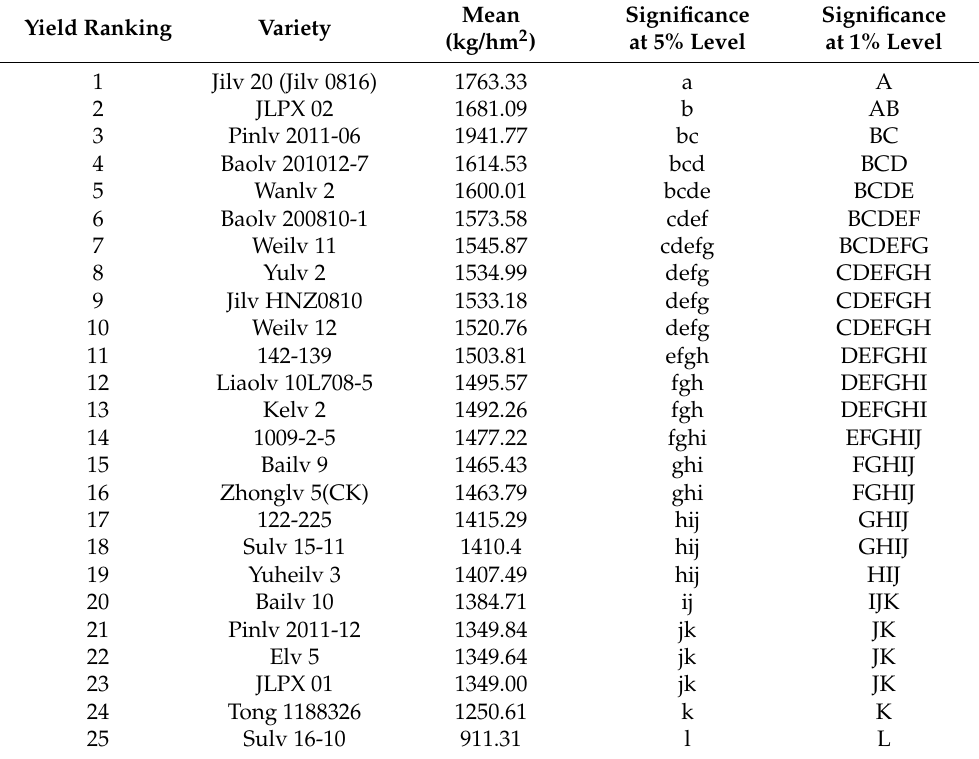
Table 6. Yield multiple comparison of 25 varieties (LSD).